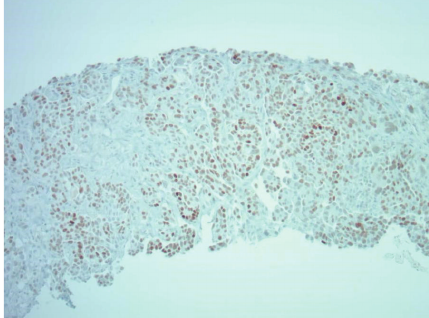
Figure 4: Thyroid biopsy: TTF1 immunostain 100x